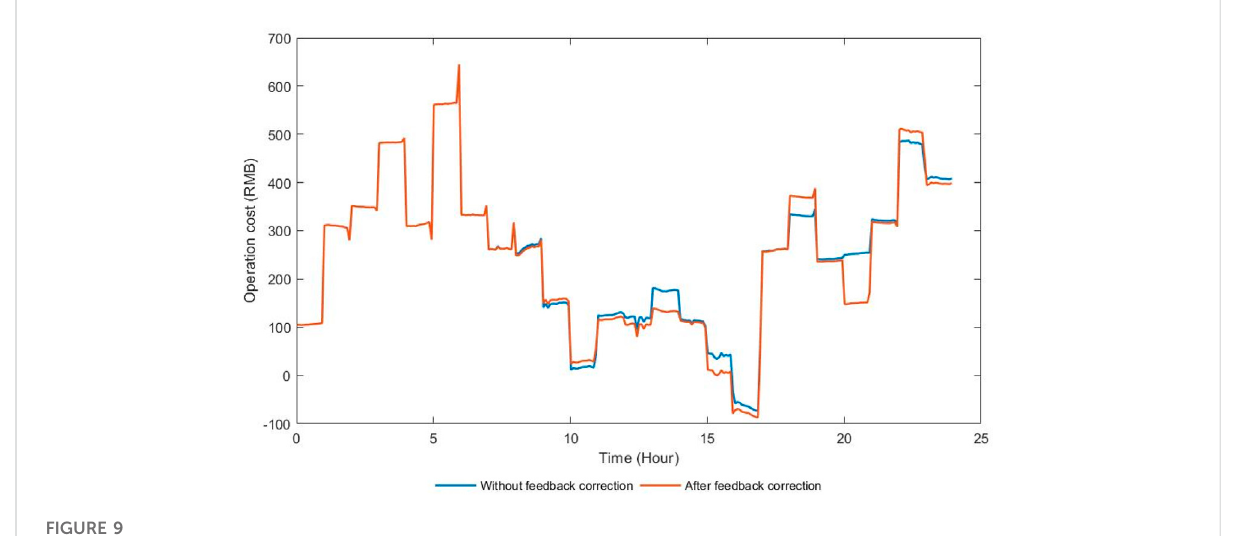
FIGURE 9 Hourly cost change of MPC rolling optimization